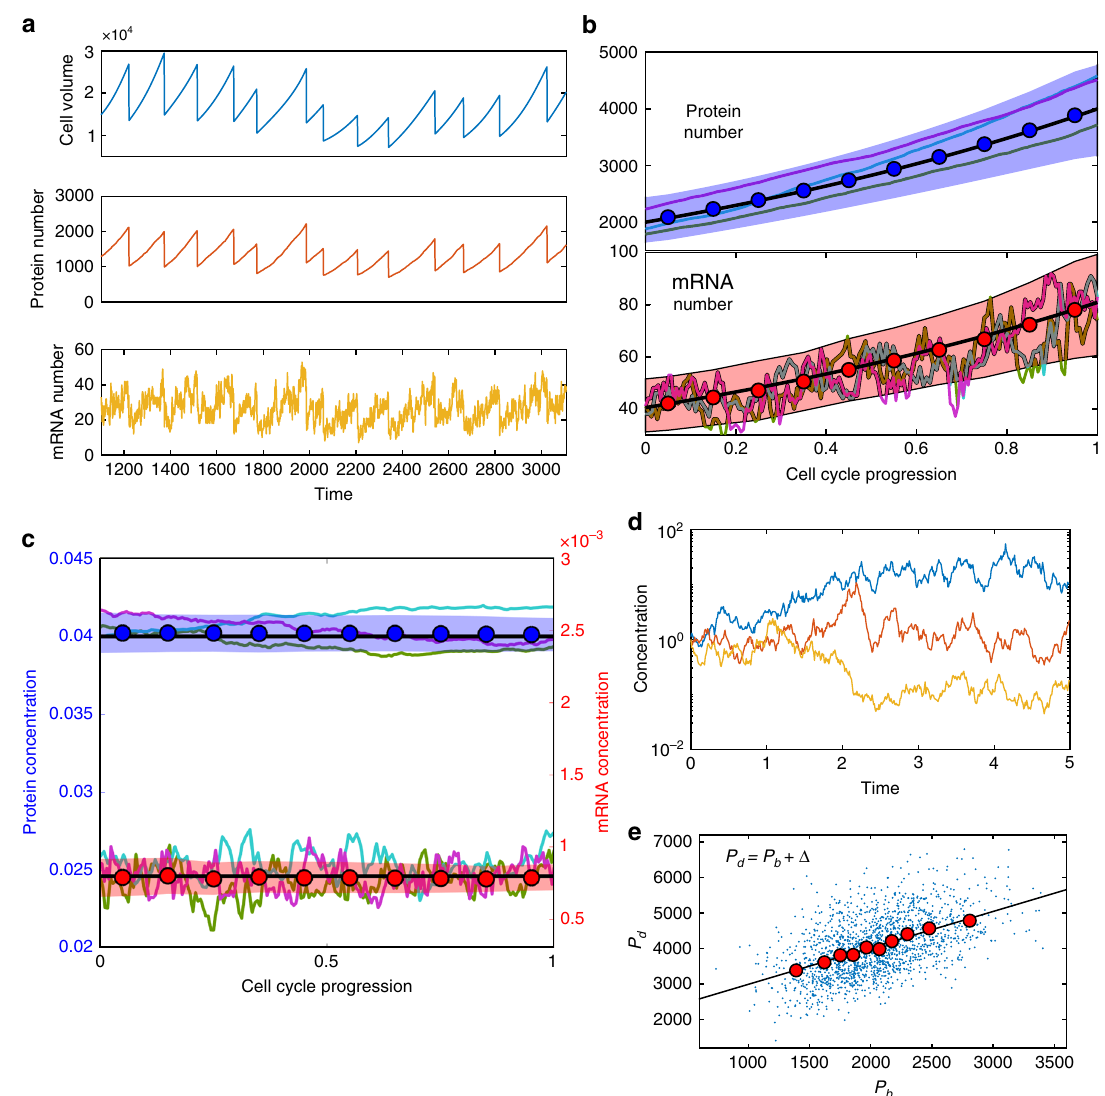
Fig. 2 Exponential growth of the cell volume, protein number, mRNA number; the homeostasis of protein and mRNA concentrations throughout the cell cycle. a Numerical simulated trajectories of cell volume, protein number, and mRNA number are shown ( ϕ i = 0.018). b The averaged values of protein and mRNA numbers of a highly expressed gene ( ϕ i = 0.04), are shown (circles) with 3 single trajectories in the background. The black lines are theoretical predictions of Eqs. (6a) and (6b). The average is over 130 cell cycles. The color band represents the standard deviation (same for ( c )). c The averaged values of protein and mRNA concentrations of the same gene as in ( b ) are shown (circles). The black lines are theoretical predictions of Eqs. (7a) and (7b). Three trajectories are shown in the background. d Three trajectories of diverging concentrations in the scenario where the protein number and cell volume grow independently. See the numerical details in Methods. e The scatter plot of the protein numbers at cell division ( P d ) v.s. the protein numbers at cell birth ( P b ). The circles are binned data. The black line is a linear fi t of the binned data with slope 1.03, consistent with the adder